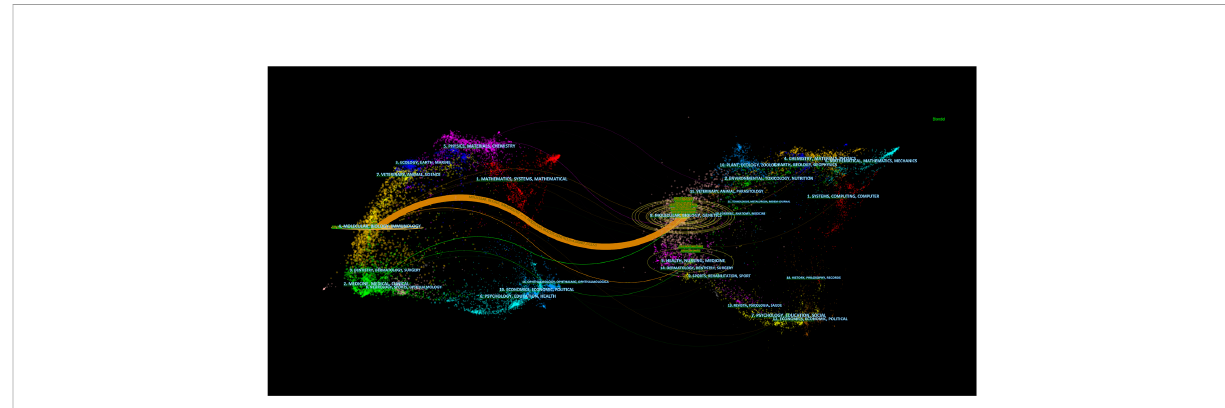
FIGURE 11 Dual-map overlay of periodicals associated with the top 100 cited references in immunotherapy-TME research. Note: Citing journals are on the left, cited journals on the right, and the colored path represents the citation relationship.